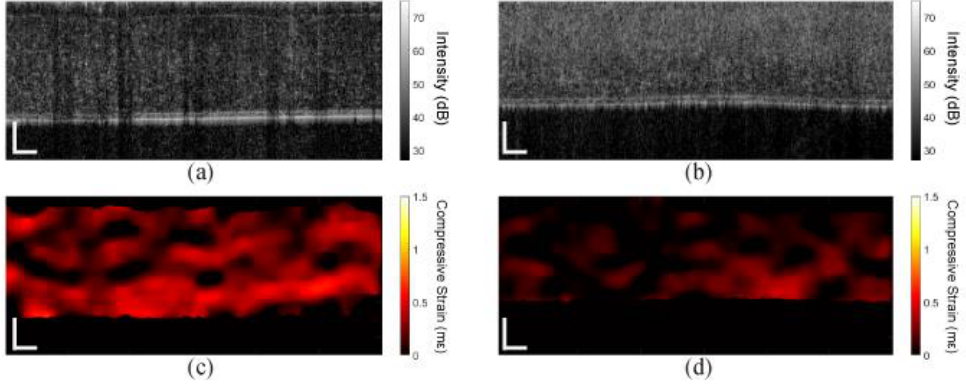
Figure 8. OCT and OCE images of the in vivo rabbit cornea. OCT images ( a ) before and ( b ) after CXL. Compressive strain maps of the cornea ( c ) before and ( d ) after CXL. Scale bars are 100 μm.